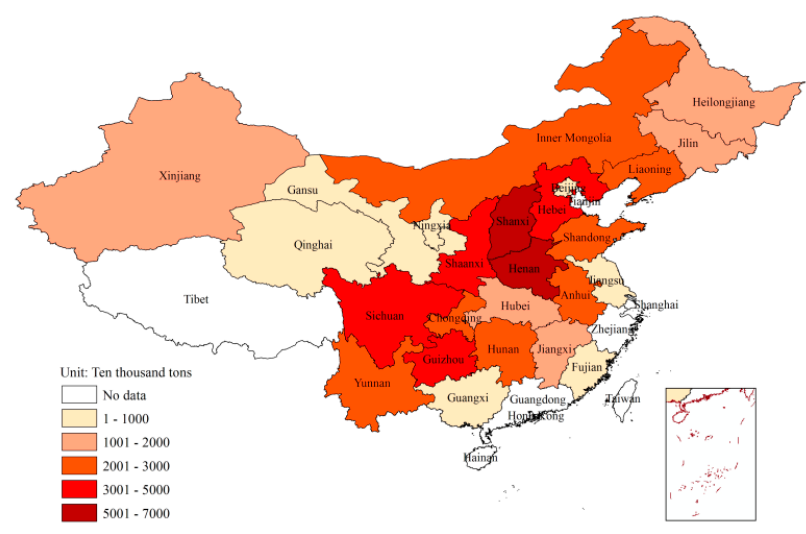
Figure 3. Spatial distribution of coal capacity cut in China.